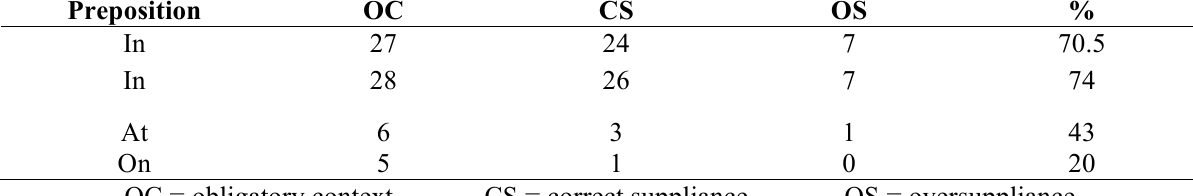
Belinda’s global accuracy for preposition (in, at, on)